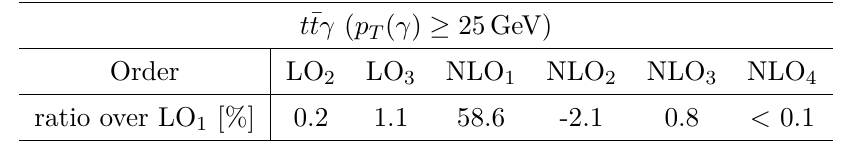
Table 2 . Relative contribution of perturbative orders entering Complete-NLO predictions for t ¯ tγ production with p ( γ ) ≥ 25 T